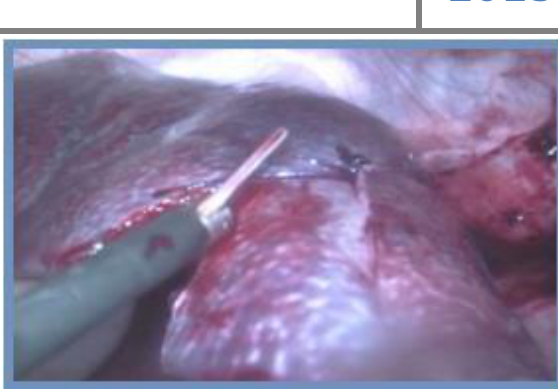
Figure, 4: Cutting part of spleen by laparoscopic scissor in group A.